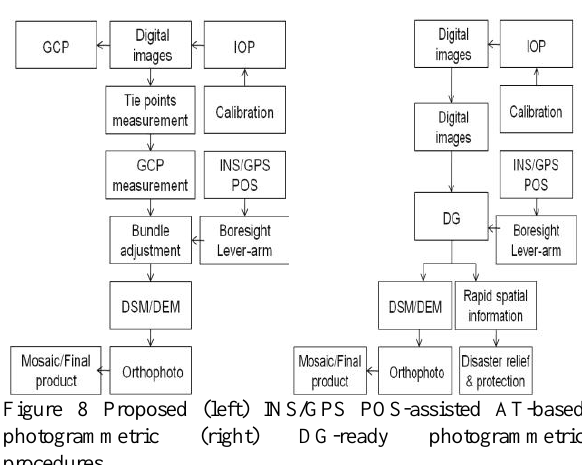
Figure 8 Proposed (left) INS/GPS POS-assisted AT-based photogrammetric (right) DG-ready photogrammetric